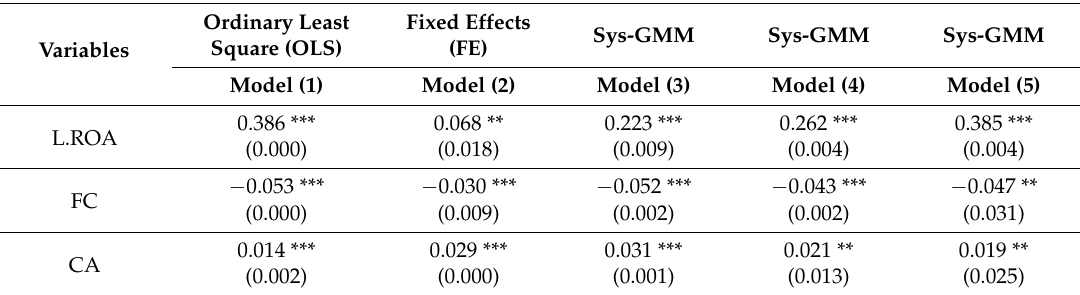
Table 5. Results for return on assets (ROA) (profitability) as dependent